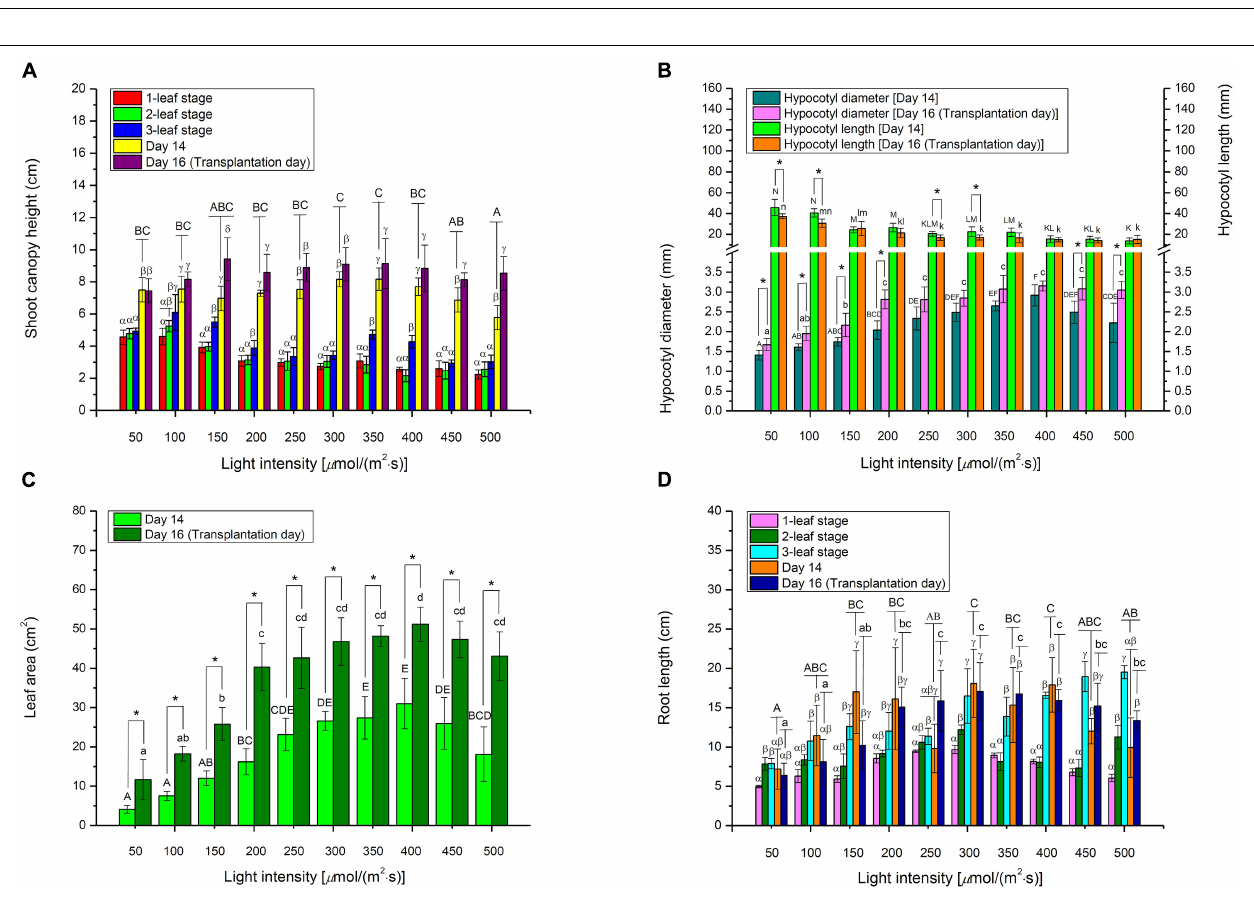
FIGURE 4 | The morphological parameters, including (A) shoot canopy height, (B) hypocotyl diameter and length, (C) leaf area, and (D) root length, of choy sum seedling grown under different white LED light intensities and growth stages. Different Greek alphabets ( α , β , γ , and δ ) showed significant differences among different growth stages as well as Day 14 and Day 16 under the same light intensity. Different upper cases (A, B, C, D, E, F, K, L, M, and N) and lower cases (a, b, c, d, k, l, m, and n) indicated significant differences across all the light intensities tested on Day 14 and Day 16, respectively ( n = 6, one-way ANOVA; Tukey multiple comparison; p < 0.05). The asterisk (*) indicates significant differences between Day 14 and Day 16 within each light intensity ( n = 6, Student’s t test, p < 0.05).